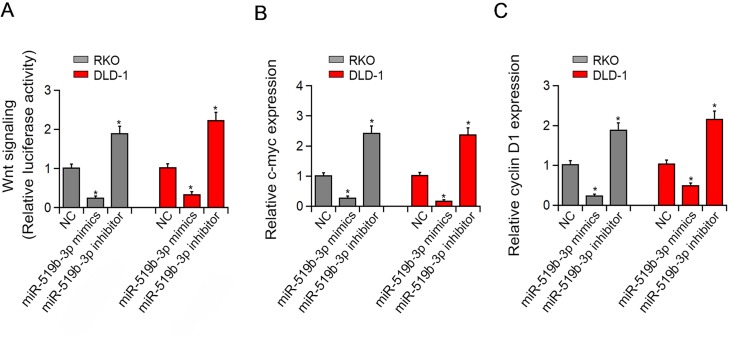
miR-519b-3p suppressed Wnt signaling in RKO and DLD-1 cells. (A) Relative luciferase activity of Wnt signaling was detected by the Dual-Glo luciferase system. (B, C) Relative mRNA expressions of c-myc and cyclin D1 were assessed by qRT-PCR. *p < 0.05 vs. NC. NC, negative control.